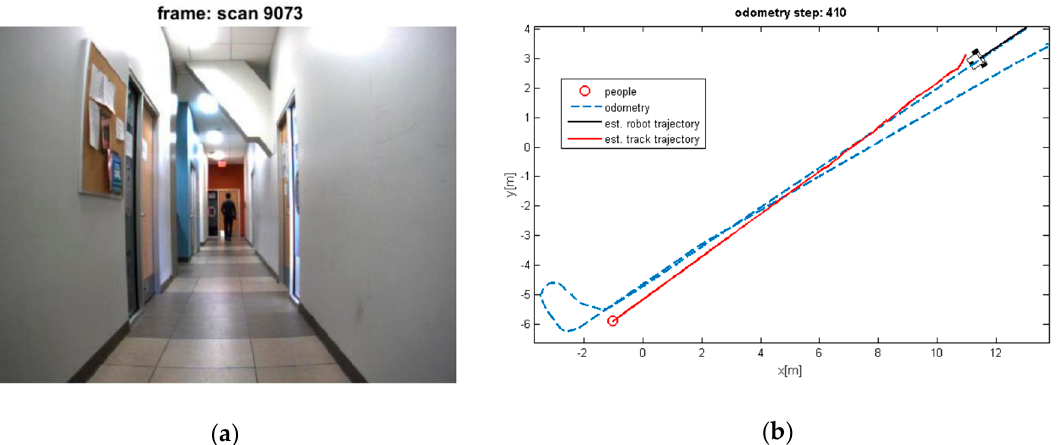
Figure 9. ( a ) Losing the detection of moving people; ( b ) Estimated trajectories of robot and tracks, whereas the proposed algorithm keeps tracking the moving object.